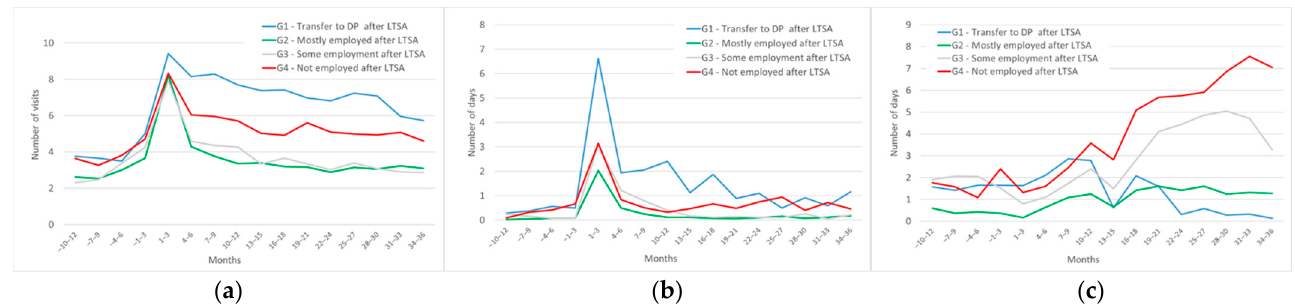
Figure 1. The use of three service types in the four LTSA groups. ( a ) Number of outpatient health care visits; ( b ) number of days in inpatient care; ( c ) number of days in rehabilitation.